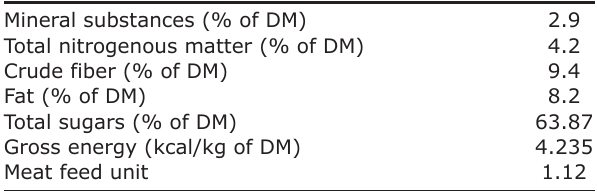
Table-1: Chemical composition of CDs. Mineral substances (% of DM) Total nitrogenous matter (% of DM)